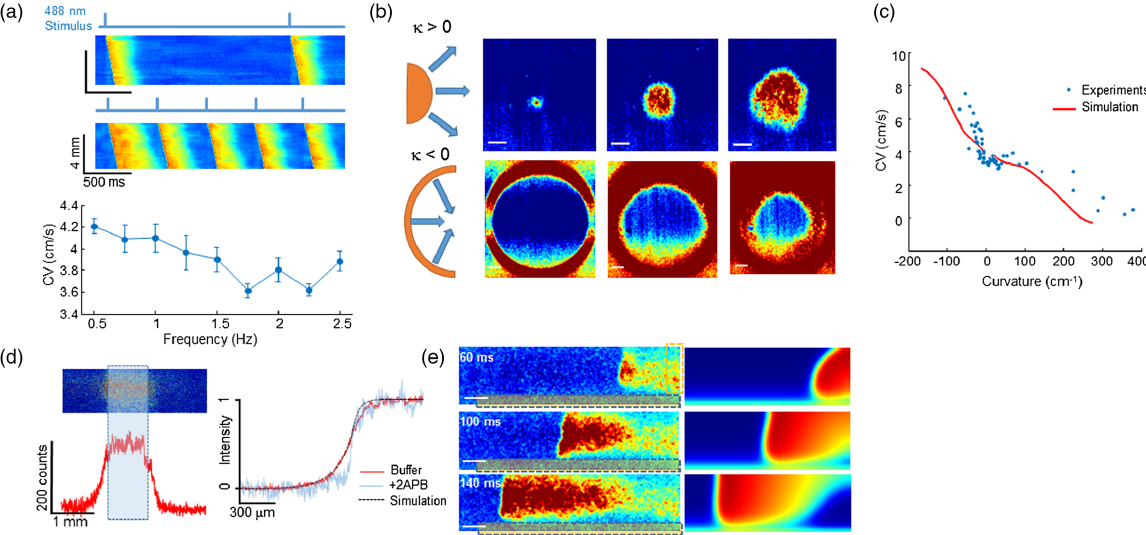
FIG. 3. Wave propagation in OS-HEK cell cultures. (a) Dispersion relation. Samples are stimulated with a vertical bar of blue light for 50 ms, 10 times in succession, with variable frequency. Movies of fluorescence are converted into kymographs by averaging parallel to the wave front. Top: Example kymographs recorded at 0.5 and 2 Hz. Bottom: Mean conduction velocity as a function of stimulus frequency. Error bars represent standard deviation of individual wave measurements within a train. (b) Curvature-dependent conduction velocity. Waves are launched either outward from a small spot (top) or inward from an annular ring (bottom) to probe positive and negative curvatures, respectively. Scale bars 500 μ m. Successive panels are separated by 10 ms. (c) Scatter plot of conduction velocities as a function of curvature (blue points). Each point represents a single frame of a particular wave. Data are compiled across several trials with differing fields of view to accommodate both low and high curvatures ( n ¼ 10 trials). Red: numerical simulations based upon Aliev-Panfilov model. (d) Static electrotonic coupling. Top: Cells are illuminated with a bar of blue illumination of sufficient intensity ( 200 mW = cm 2 ) to saturate CheRiff photocurrent. Bottom: Mean QuasAr2 intensity profile transverse to the bar of illumination. The CheRiff-induced depolarization spread laterally away from the illuminated zone. Right: Comparison of measured depolarization profile to a numerical fit based on the Aliev-Panfilov model with a coupling length of 300 μ m. A gap junction blocker (2-aminoethoxydiphenyl borate) suppresses the lateral spread of depolarization. (e) Static illumination guides to propagation. Left: Awave is launched adjacent to a region of static illumination (indicated with dotted box on the bottom of the images). The wave propagates parallel to the boundary, with local inhibition adjacent to the boundary. Right: Comparison to simulations of the Aliev-Panfilov model. Scale bars 500 μ m. See Movies 7 and 8 in Supplemental Material